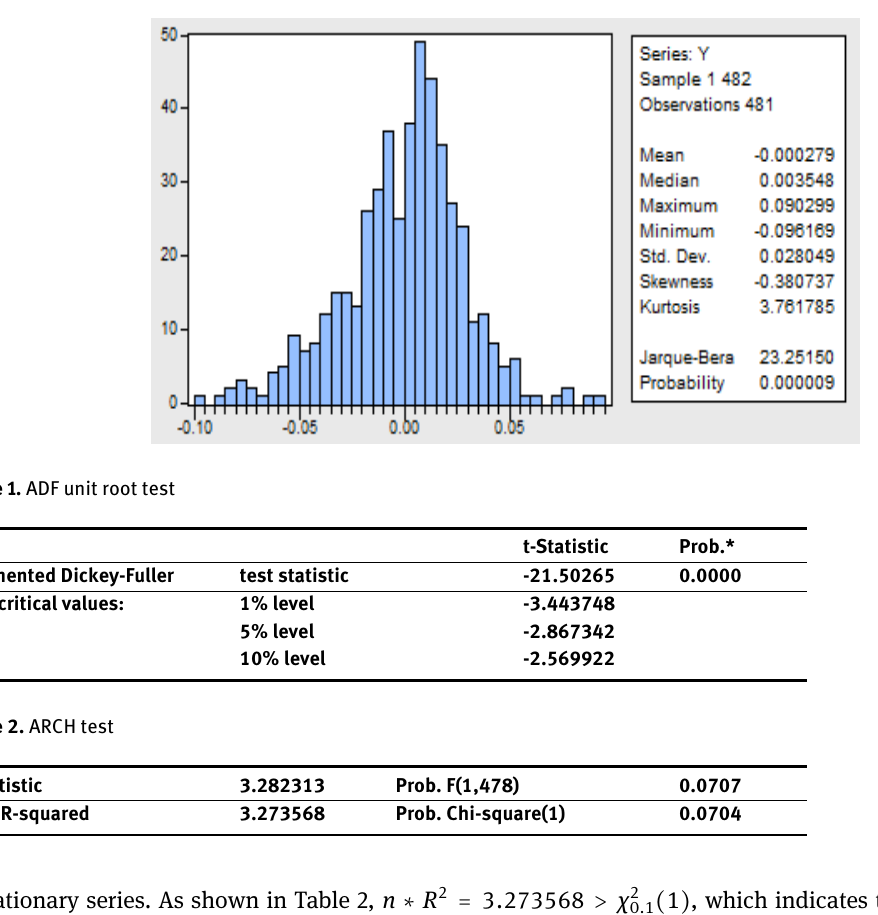
Fig. 1. Log-return descriptive statistics of CSI 800